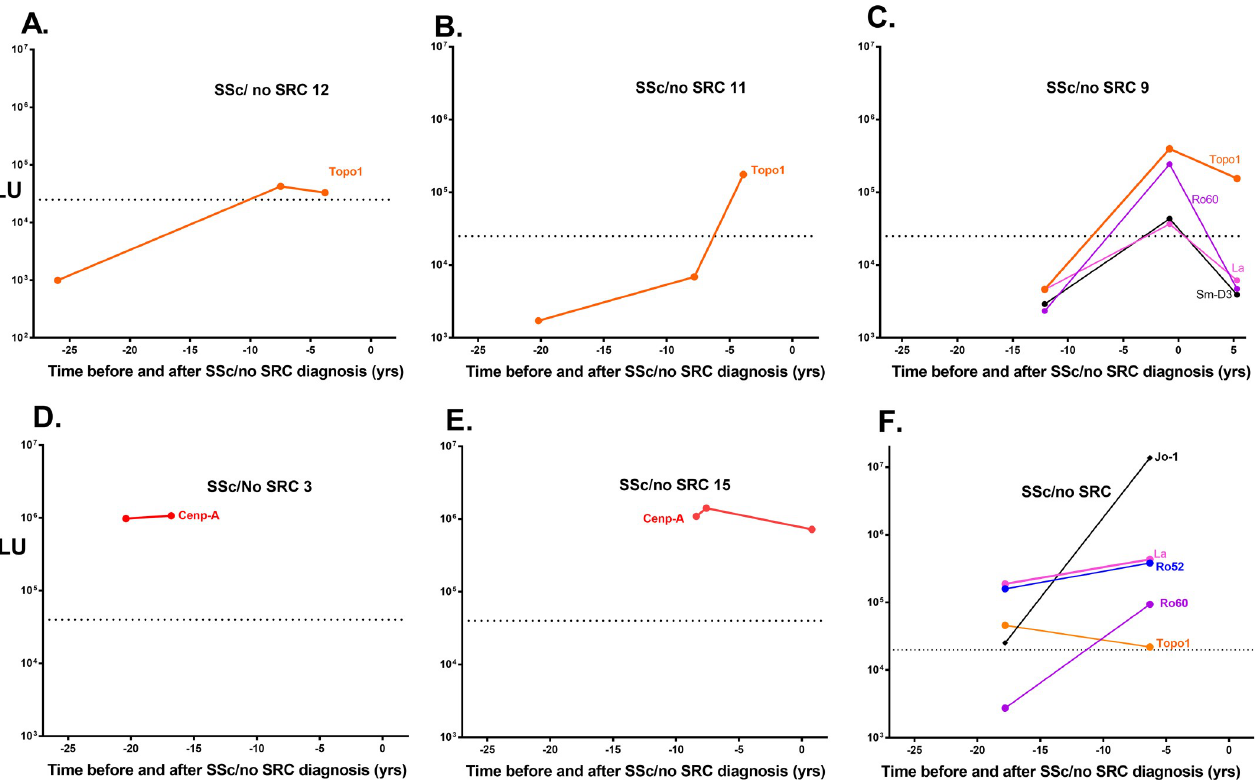
Fig 5. Representative autoantibody profiles seen before diagnosis of SSc/no SRC. Representative plots illustrating autoantibody levels in the six SSc/ no SRC subjects before diagnosis of the disease. The X-axis denotes the time in years before diagnosis. The left Y axis represents the scale of the autoantibody levels in LU and the dotted line represent the cut-off values for the antigens. All seropositive antibody responses against the autoantigen panel are shown.